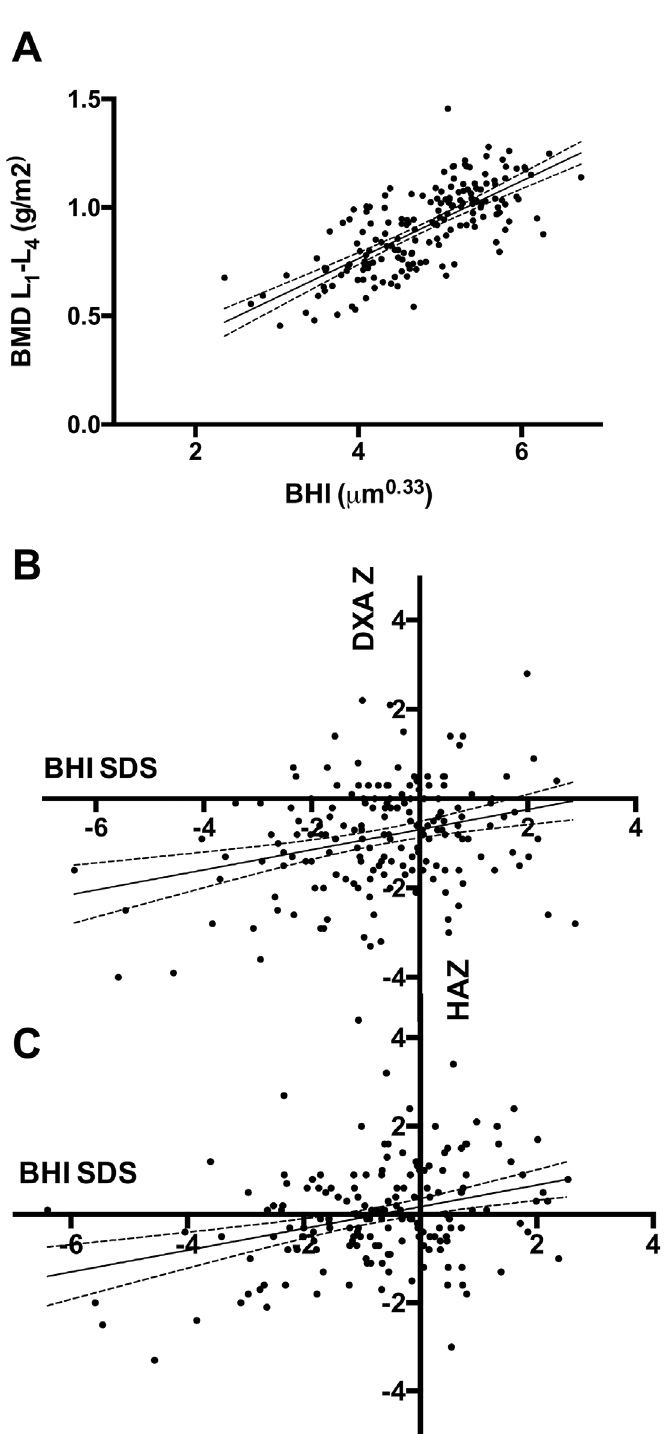
Fig 1. Positive association of BMD values obtained via BoneXpert and DXA scan. A) BMD readings of the lumbar spine (L1-L4) obtained by Lunar Prodigy (GE Healthcare) as a function of BHI obtained by BoneXpert (r = 0.73; P < 0.0001). B) Age-adjusted DXA Z-scores as a function of BHI SDS obtained via BoneXpert (r = 0.23; P = 0.02). C) DXA-Z scores, adjusted for patient height (HAZ) as a function of BHI SDS using BoneXpert (r = 0.27; P < 0.0001). For all figures, the predicted values based on bivariate regression analysis are indicated as solid line. The dashed lines represent the 95% confidence interval.